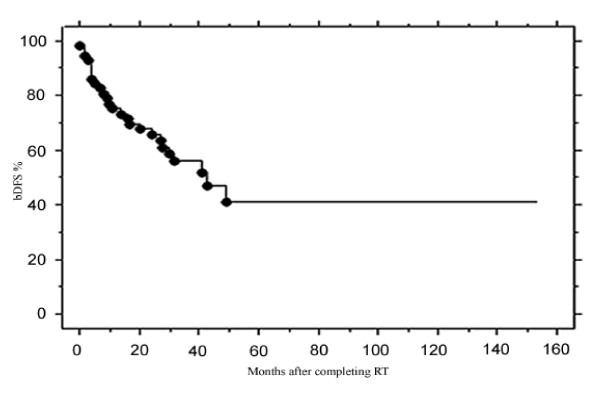
bDFS after the end of RT according to PSA >0.2 ng/ml definition.